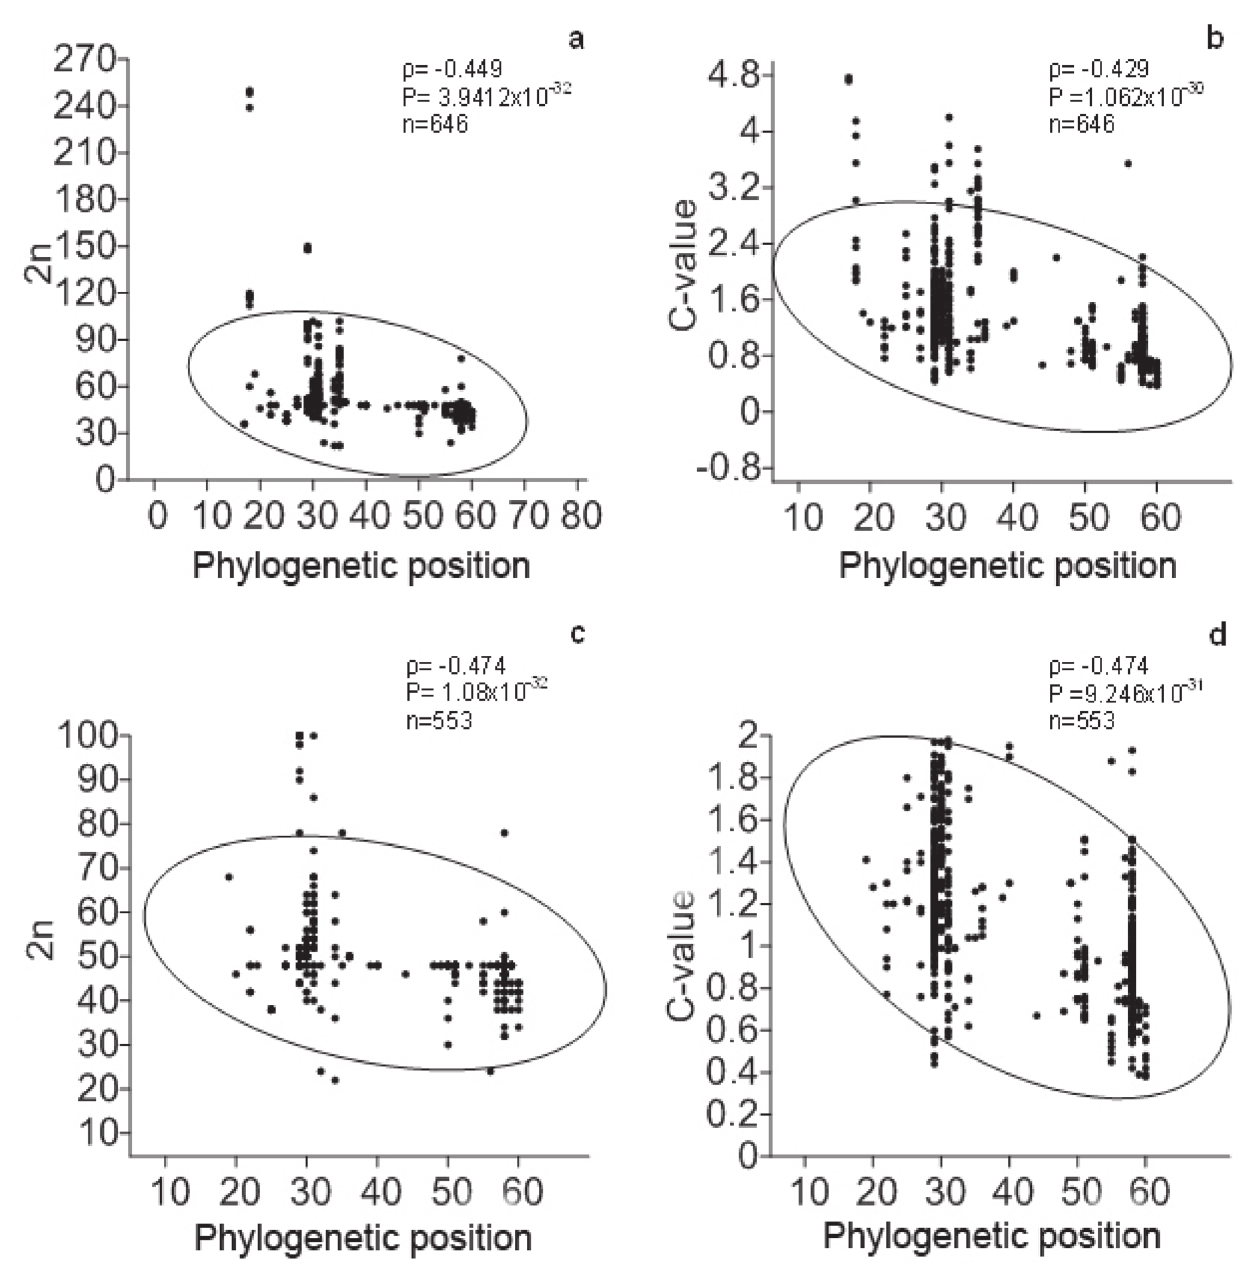
Fig. 2. Scatter-plot of (a, c) diploid number (2n), and (b, d) pg of DNA per haploid nucleus (C-Value), against the phylogenetic position of Actinopterygii families presented by Nelson (2006). Data include all available species (a, b) or exclude possible polyploidy species (c, d). Ellipses with 95% confidence are used as a correlation